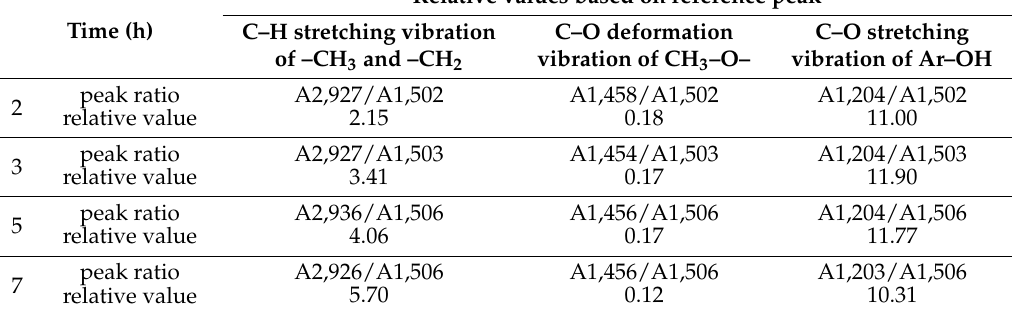
Table 4. Relative values of functional groups on D-WSALs under nitrogen atmosphere for 7, 5, 3, and 2 h (phenyl group’s skeleton vibration peak at 1503 cm − 1 was selected as the reference, the relative values of other groups by area ratios of the peaks were calculated).